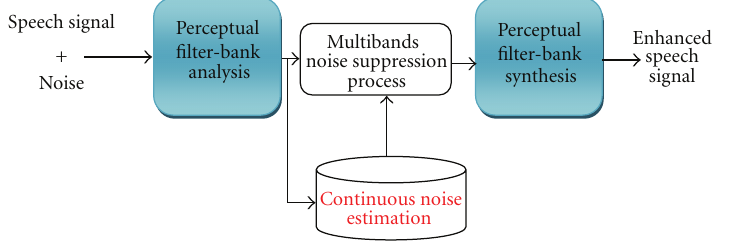
Figure 1: Proposed speech enhancement method based on perceptual filtering